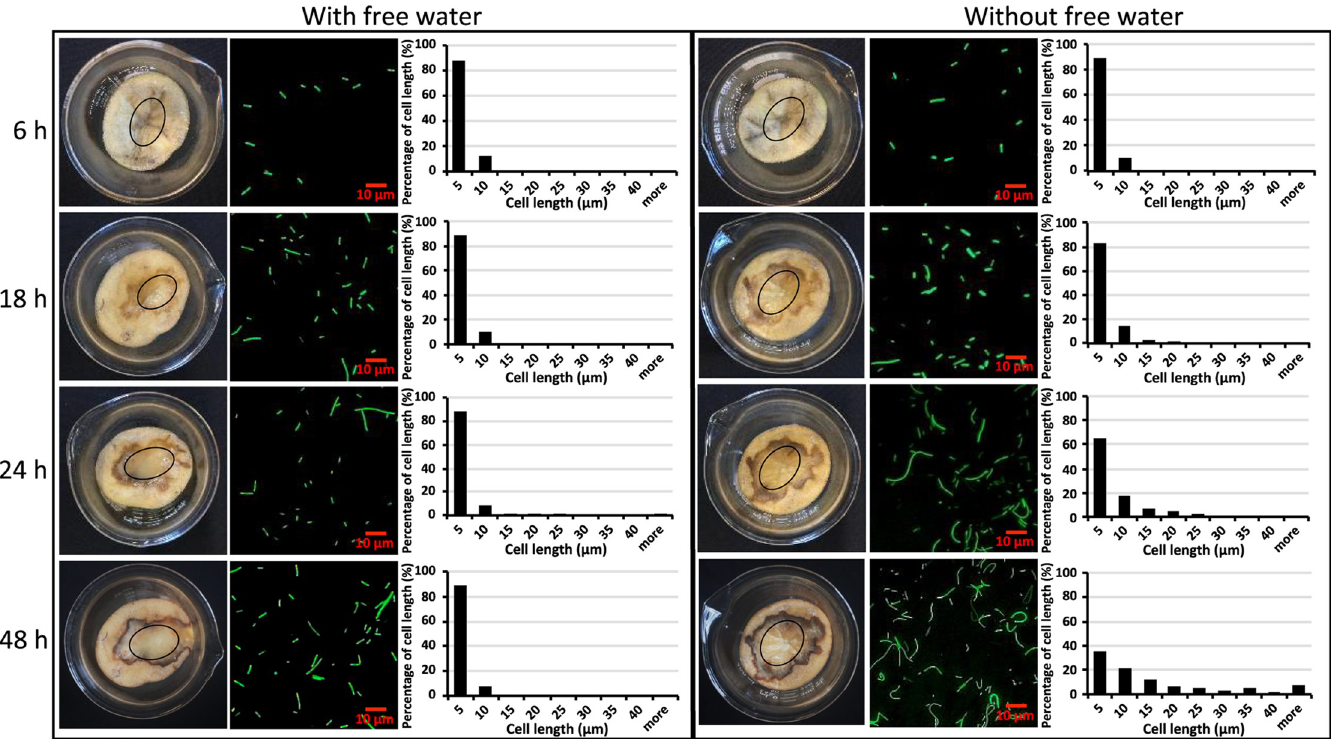
Fig 3. Impact of infection stage and freestanding water on the distribution of filamentous cells and short cells of D . dadantii on potato tubers. Symptoms, cell morphology and length distribution of D . dadantii at different stages of infection (6, 18, 24, and 48 hpi) on potato tuber in the presence and absence of freestanding water. Circles on the symptom images represent the sampling area. For potato tubers with freestanding water (left panel), 0.5 ml of sterile distilled water was added to the surface of potato tubers every 4 hr. The experiment was repeated five times with similar results. https://doi.org/10.1371/journal.ppat.1007703.g003 PLOS Pathogens| https://doi.org/10.1371/journal.ppat.1007703 August 5,